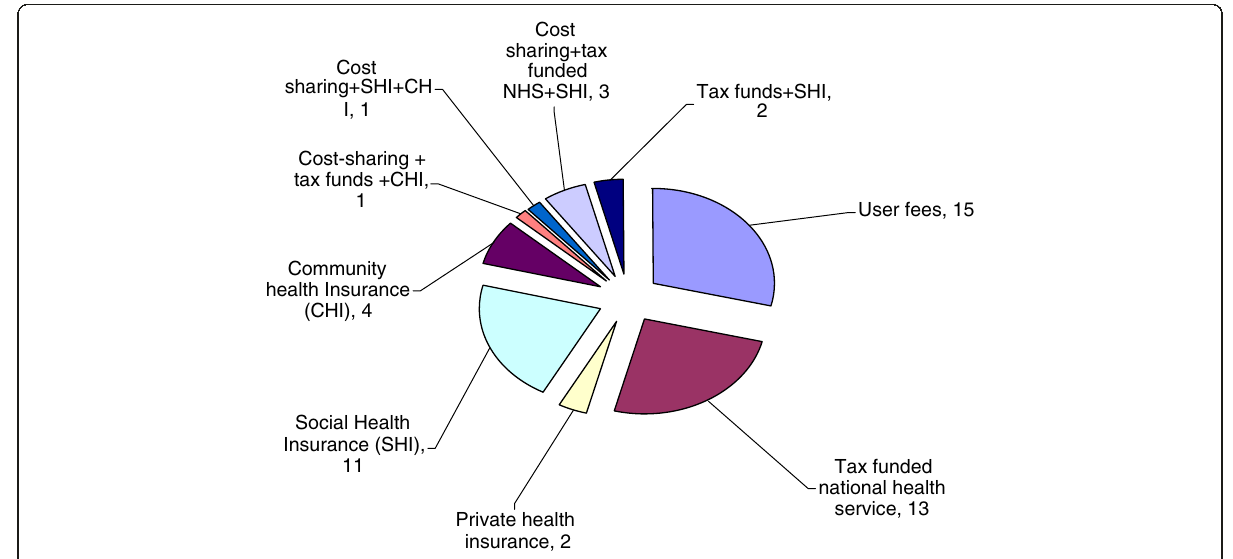
Figure 4 Number of respondents choosing revenue collection mechanisms.